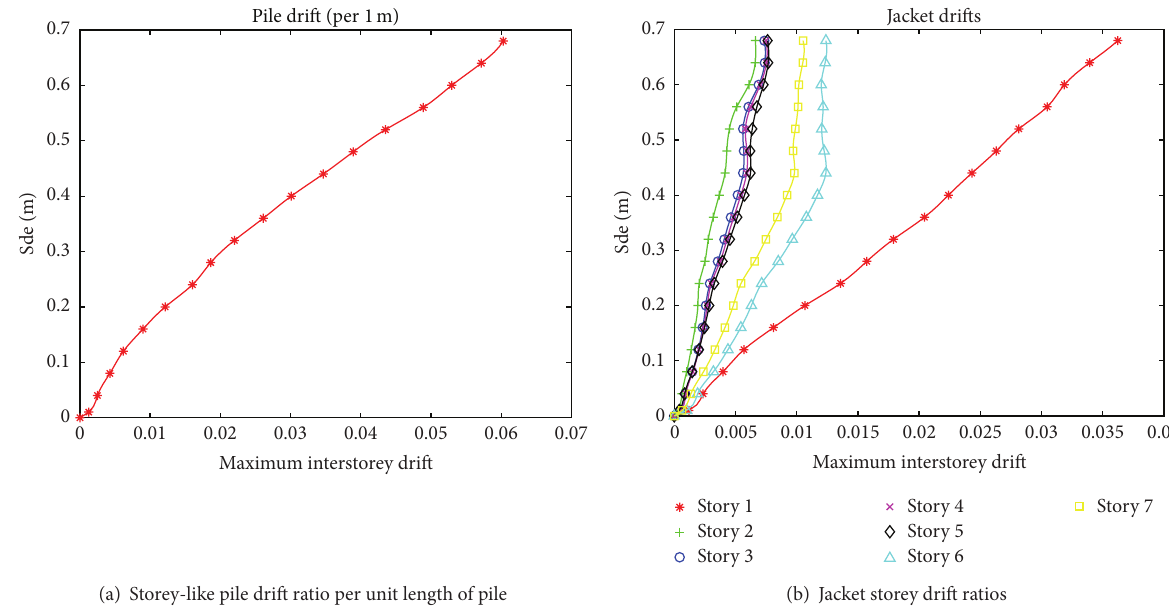
Figure 4: IDA curves of record number 4 for original platform.